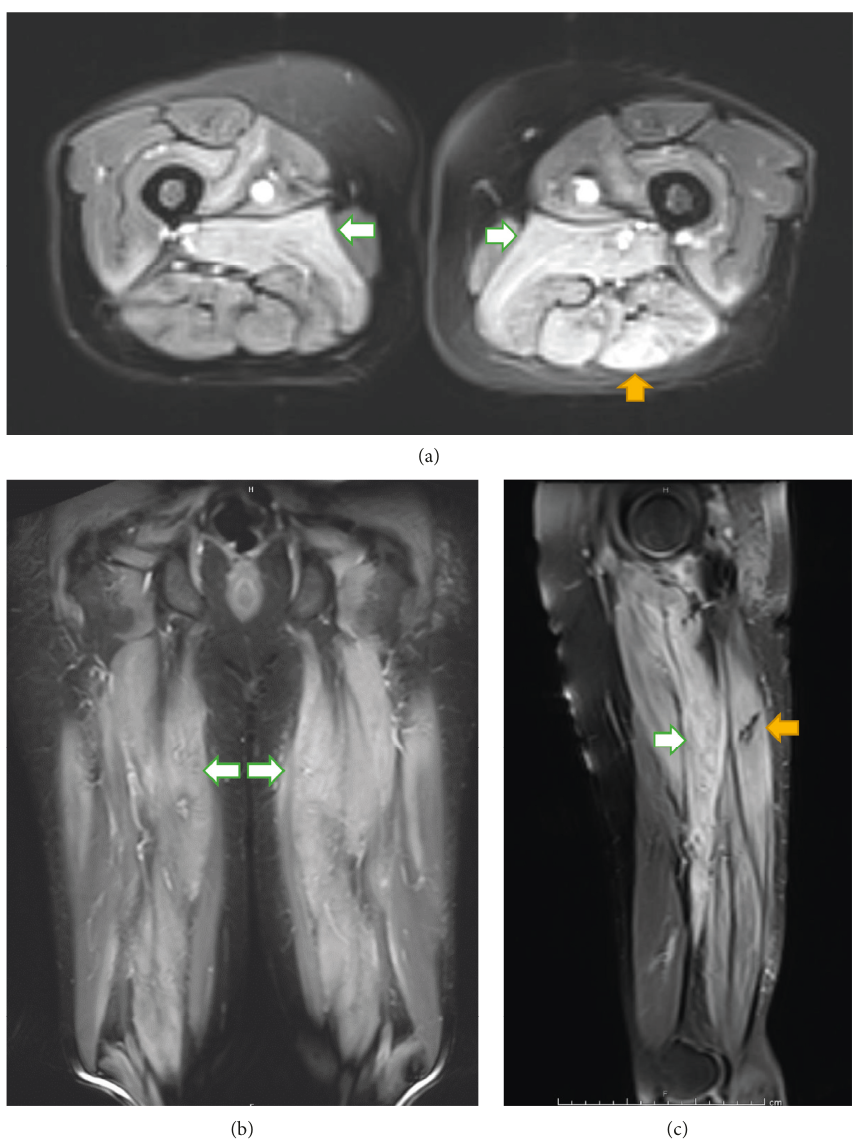
Figure 1: MRI of both thighs ((a) T2 tse fat sat axial, (b) T2-tirm-fs coronal, and (c) T2 tse-fs sagittal left thigh) showing a considerable degree of slightly heterogenous relative hyperintensity of the adductor muscles of both thighs (white arrows) as well as the hamstring muscles of the left thigh (yellow arrows) with no gross increased volume of the muscles appearance. These findings raise the possibility of partial atrophy and intrasubstance edema possibly due to the effects of chronic myositis/myopathy with secondary early muscle atrophic